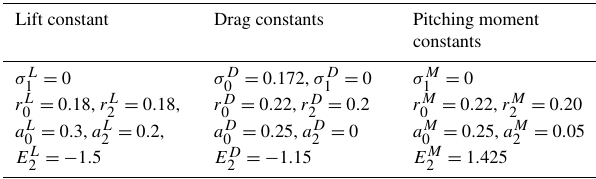
Table 1. ONERA model constants used in hGAST.